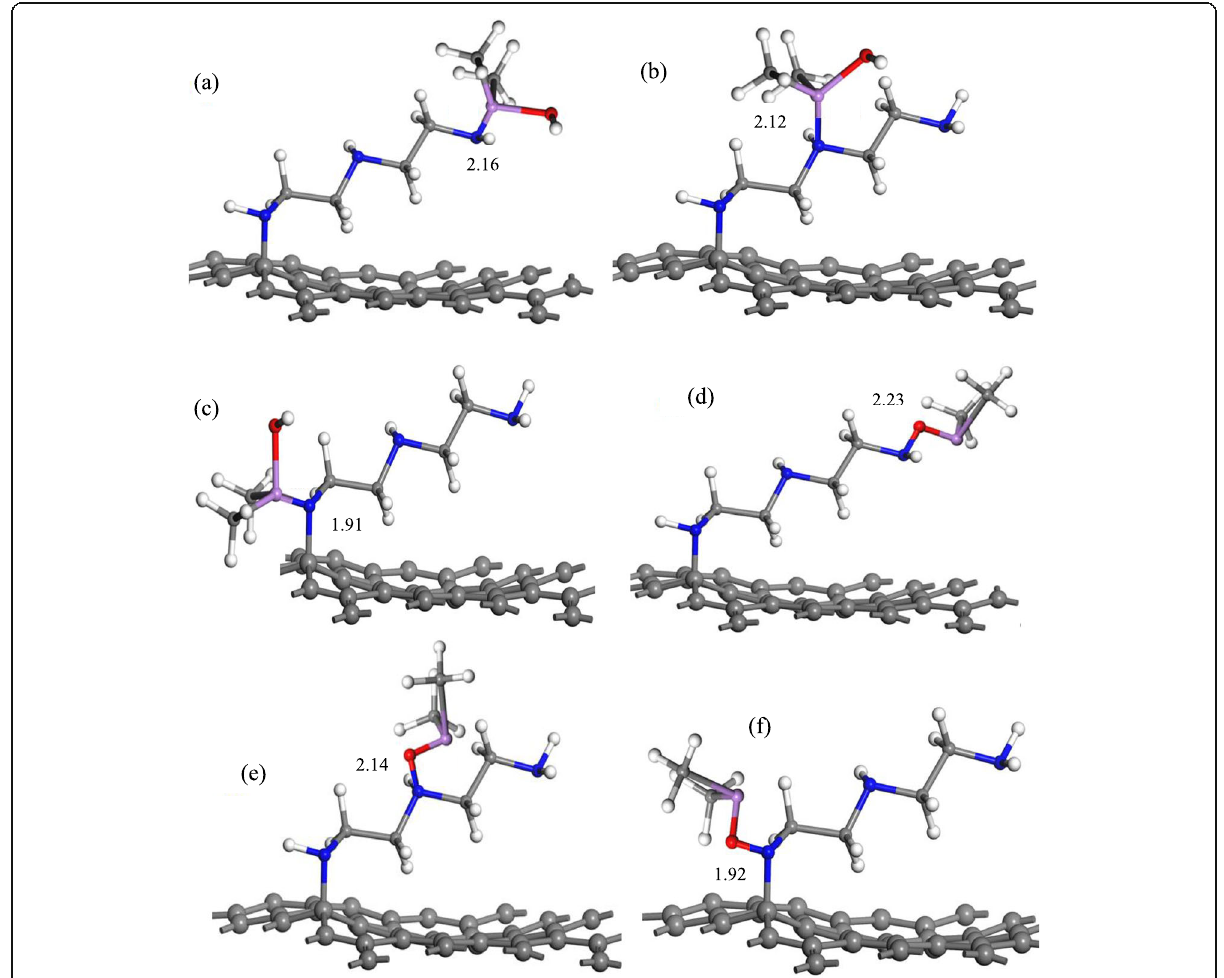
Fig. 11 The possible adsorption configurations of DMA on DETA-SBC